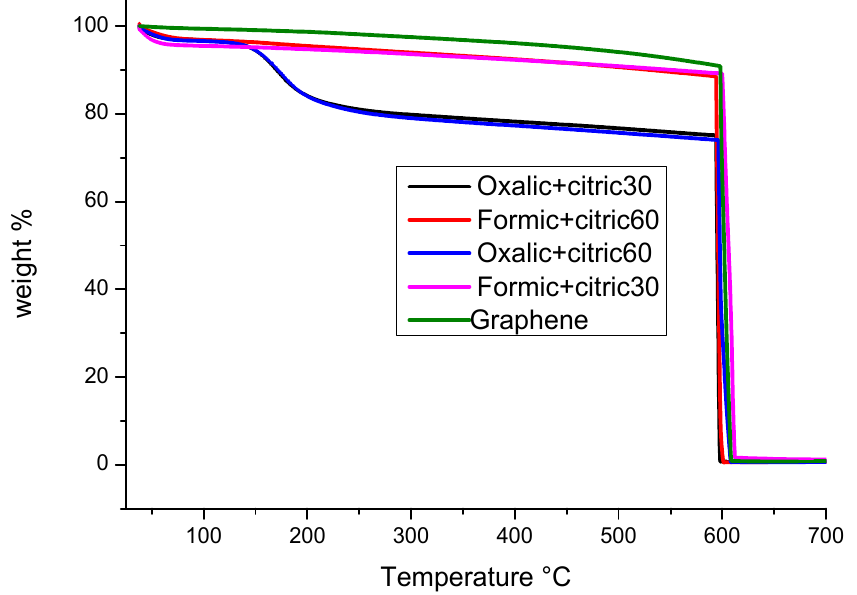
Figure 6. Thermogravimetric analysis (TGA) analysis of graphene and the modified samples with organic acids.